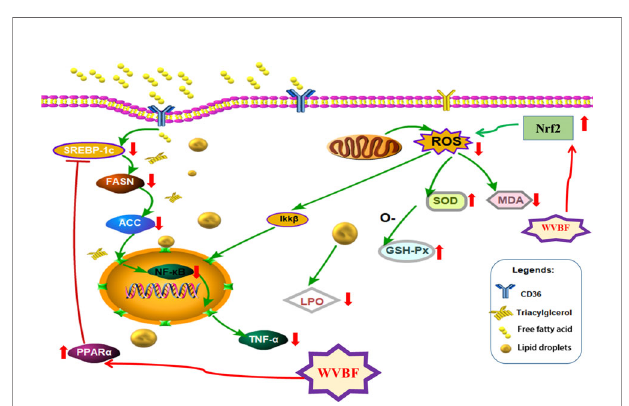
FIGURE 9 | The protective mechanism of water extract of Veratrilla baillonii (WVBF) on free fatty acids (FFA)-induced non-alcoholic fatty liver disease (NAFLD) LO2